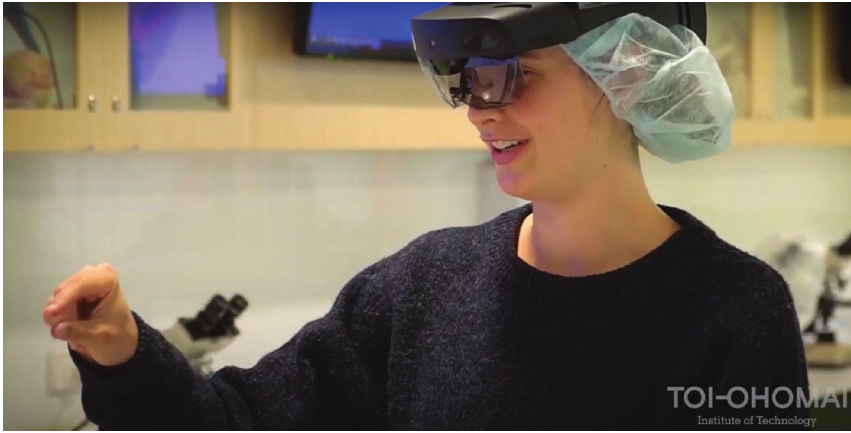
Figure 4. Using the GIGXR anatomy app on HoloLens 2 at Toi Ohomai / Te Pūkenga in